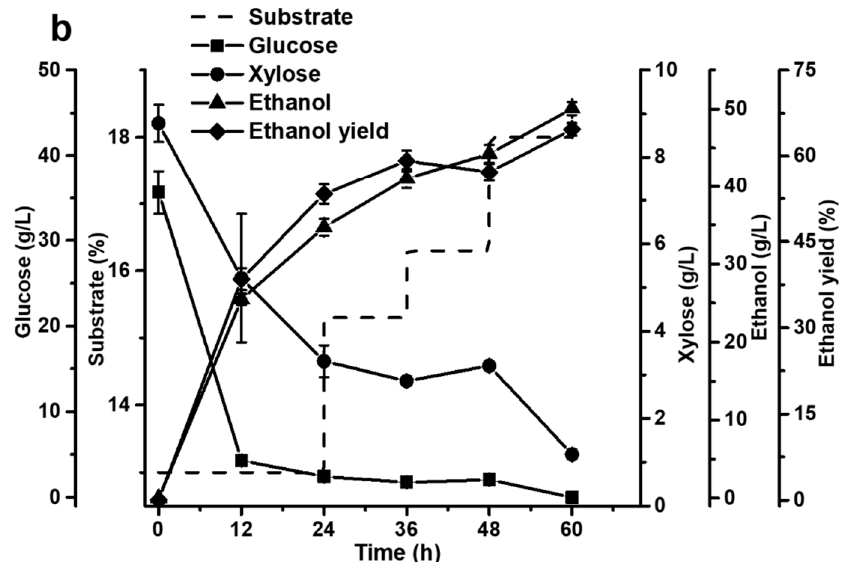
Figure 3. Changes in ethanol yield and concentrations of substrate, glucose, xylose, and ethanol in fed-batch S-SSF of AS-pretreated corn stover using Angel S. cerevisiae ( a ) and S. cerevisiae XH7 ( b ). Substrate: dotted line; Glucose: square; Xylose: circle; Ethanol: triangle; Ethanol yield: rhombus.